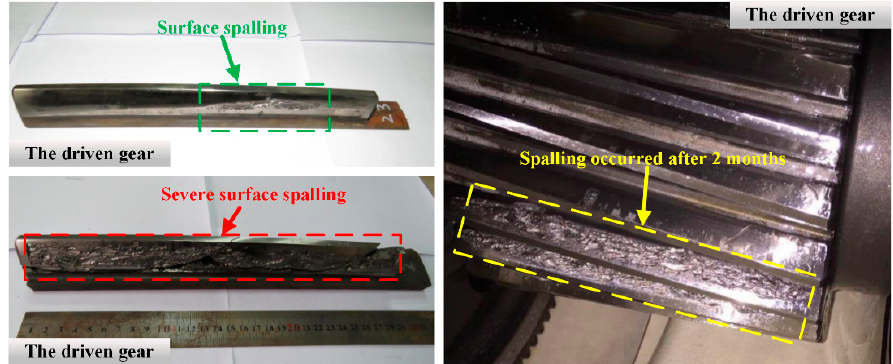
Figure 1. The failures observed in wind turbine gears related to micropitting.